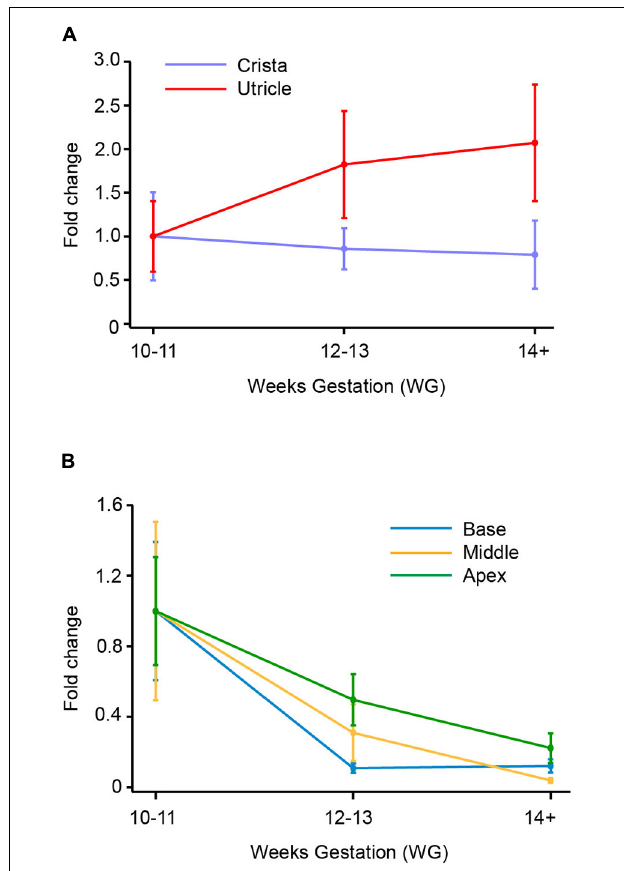
FIGURE 4 | SCN10A (Nav1.8) mRNA in vestibular organs and cochlea. (A) In crista there was a decrease in expression of SCN10A between 10–11 WG and 14+ WG. At 14 WG, SCN10A expression was 0.8-fold less than that observed at 10–11 WG. In contrast, in the utricle, SCN10A expression steadily increased to peak at 14+ WG where expression was twofold greater than the youngest age. (B) In the base, middle, and apex of the cochlea there was a consistent decrease in expression of SCN10A between 10–11 WG and 14+ WG. SCN10A expression was lowest at 14+ WG within the cochlea, decreasing to 0.003-fold in the middle region of the cochlea.